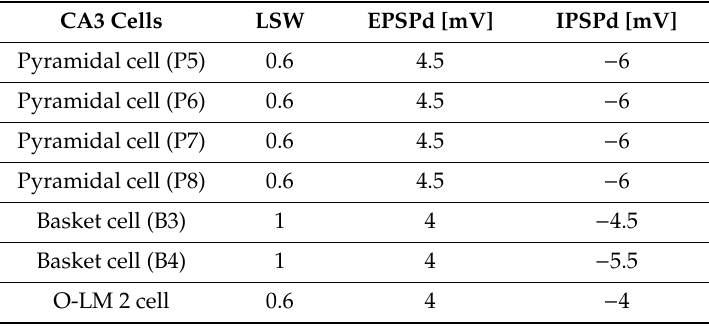
Table 2. Initial parameters microcircuit model of CA3